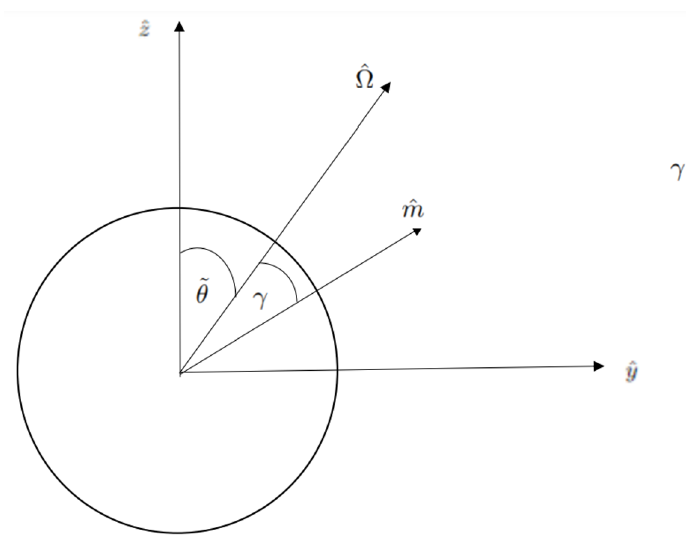
Figure 1 . Schematic of the NS showing the different angles. The rotation axis makes a ˜ θ angle with the z axis and the magnetic dipole moment makes a constant γ angle with the rotation axis, while precessing around it with Ω angular